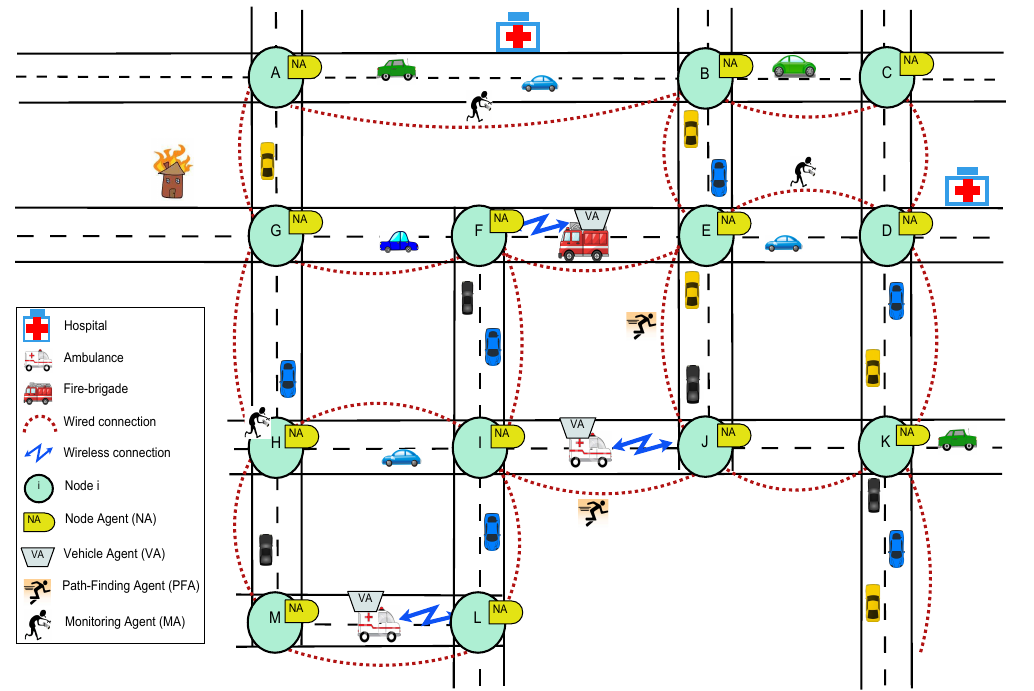
Figure 1. A Conceptual view of the Agent based Digital Traffic Infrastructure Network